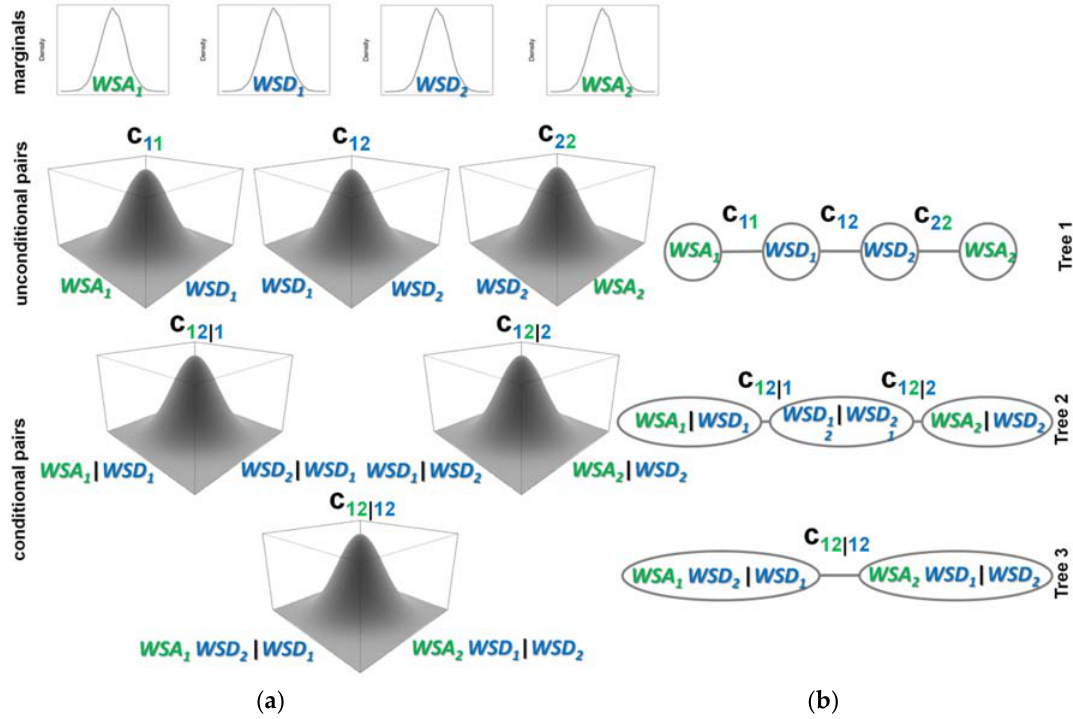
Figure 2. Example of components of a Vine copula to model events occurring simultaneously in two stations. ( a ) Marginal densities, unconditional and conditional pair copula densities (under N(0, 1) margins for visualization). ( b ) Vine tree structure.